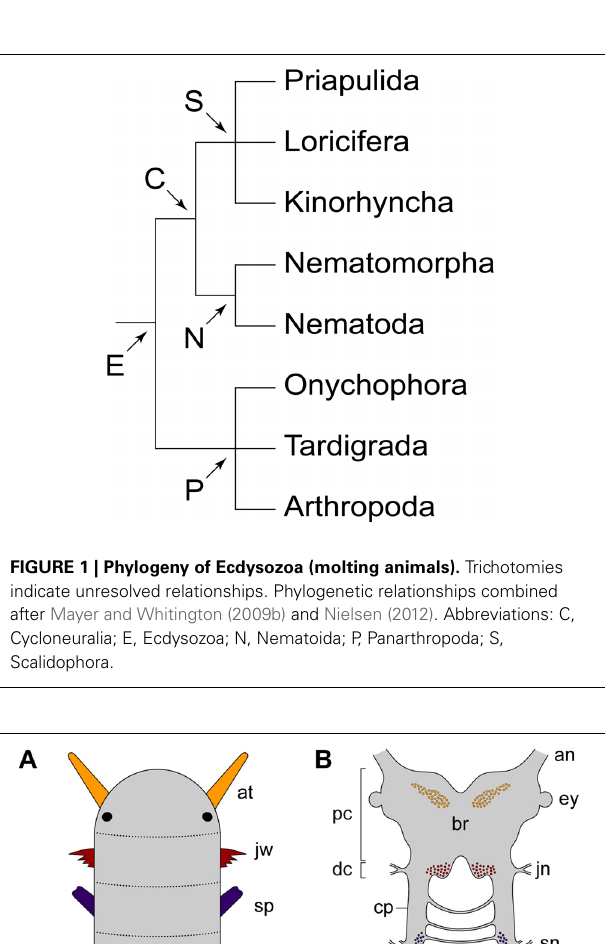
the tritocerebrum of arthropods (Mayer et al., 2010). The